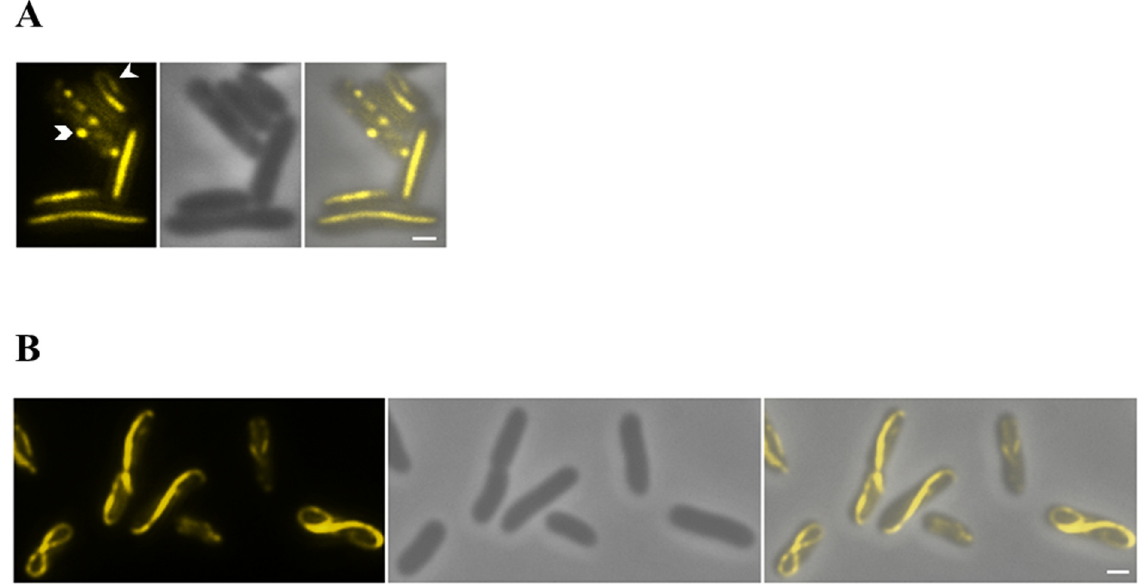
Fig 3. ParM-YFP filament formation in the presence or absence of parC and ParR. E . coli cells expressing ParM-YFP in isolation (A) or expressing ParM-YFP in the presence of parC and ParR (B) were visualized by fluorescence microscopy. ParM-YFP filaments exhibit a dramatic shift in morphology in the presence of parC and ParR. Hook shaped filaments are indicated with an arrow-head, and ParM-YFP foci are shown with a chevron. Left to right, both panels: fluorescence image, phase contrast image; merge of phase contrast and fluorescent images. Scale bars represent 1 μ